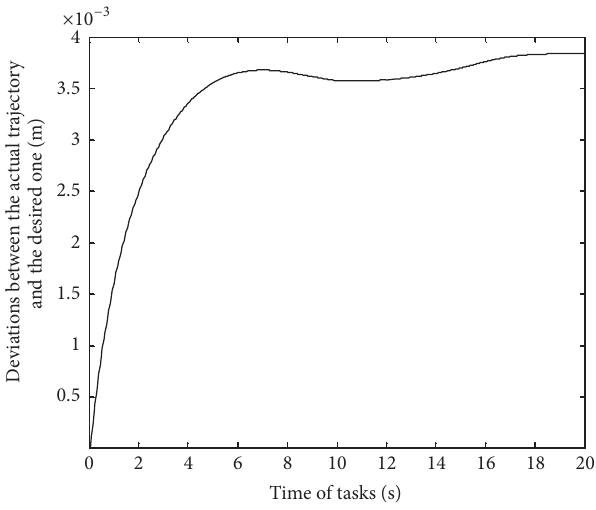
Figure 7: Position deviations in operation space after velocity